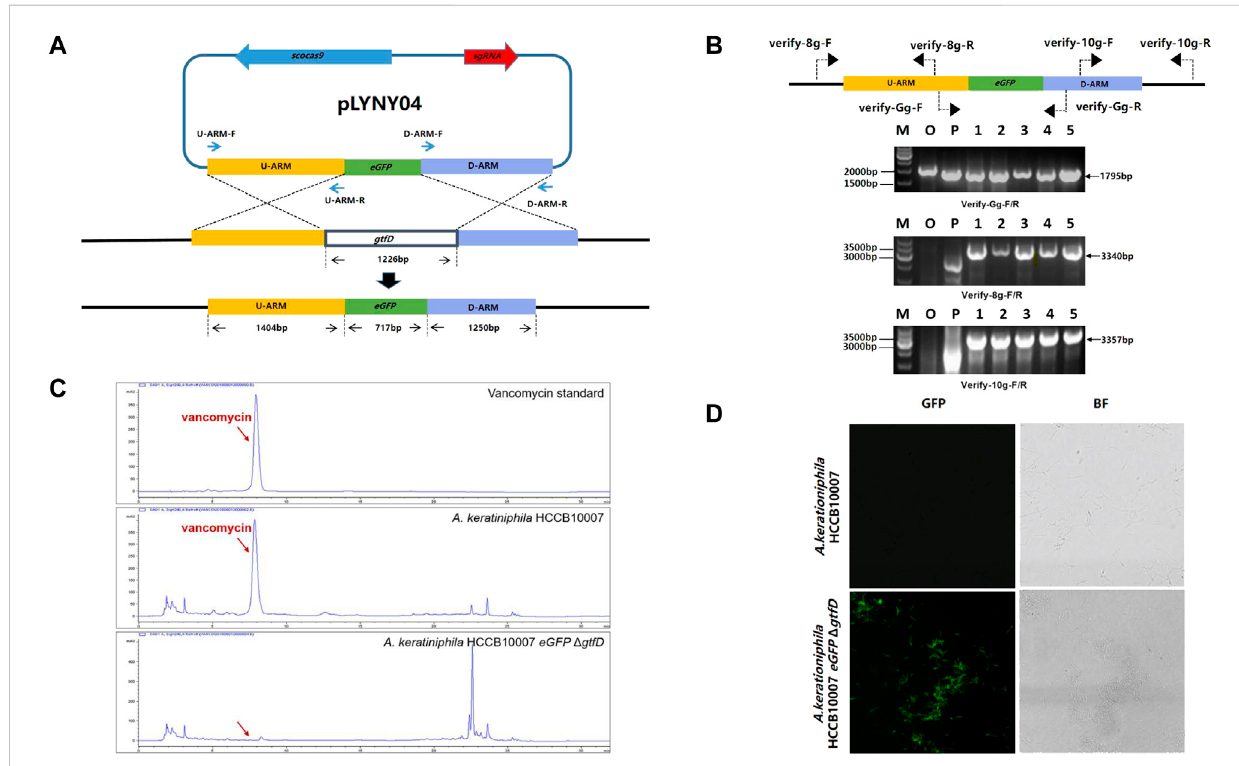
FIGURE 2 CRISPR/Cas9-mediated the deletion of gtfD and the insertion of eGFP in A. keratiniphila. (A) Strategy for replacement of gtfD by eGFP with CRISPR/ Cas9-mediated editing plasmid pLYNY04. Scocas9 introduced DSB within gtfD gene, which could then be precisely repaired by a donor DNA fragment containing eGFP and the fl anking upstream and downstream homologous arms. (B) PCR ampli fi cation analysis of randomly selected transformants veri fi ed the simultaneous gtfD deletion and eGFP insertion. The 1795 bp amplicons represented the replacement of gtfD by eGFP , and the 3340bp and 3357bp PCR amplicons veri fi ed the insertion of eGFP . M, GeneRuler 1 kb DNA Ladder (Thermo Scienti fi c). O, original strain A. keratiniphila HCCB10007. P, pLYNY04. Lanes 1 – 5, colonies transformed with pLYNY04. (C) HPLC analysis of vancomycin from the original strain A.